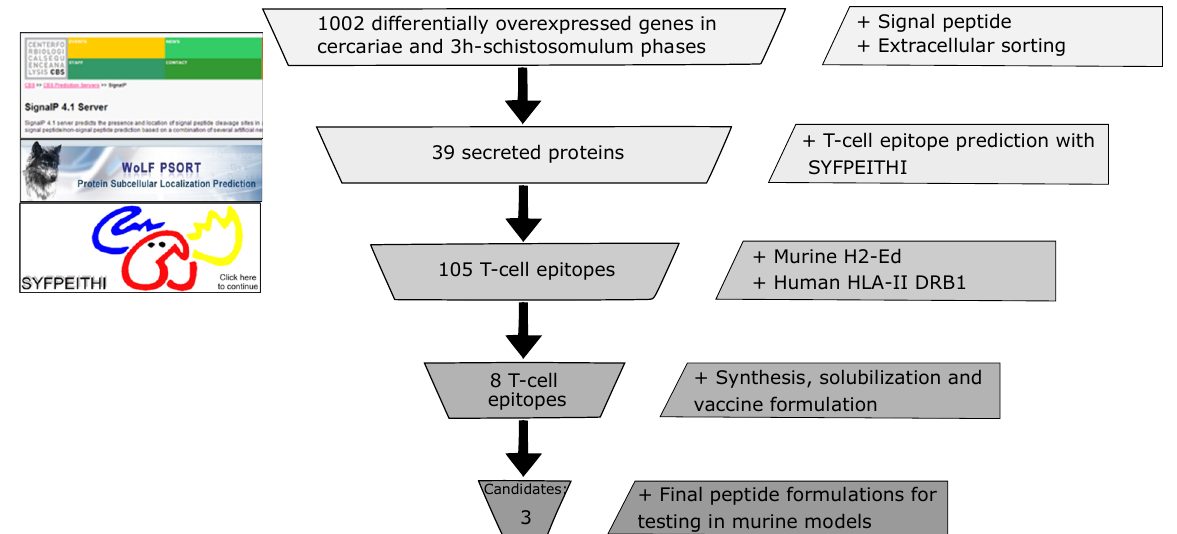
Figure 1. T cell epitopes prediction and selection derived from overexpression in Schistosoma mansoni from the cercaria stage to 3-h schistosomulum stage having highly potential host–parasite interaction based on the presence of a signal peptide (SignalP 4.1), subcellular location (WoLF PSORT) and T cell peptide prediction (SYFPEITHI).